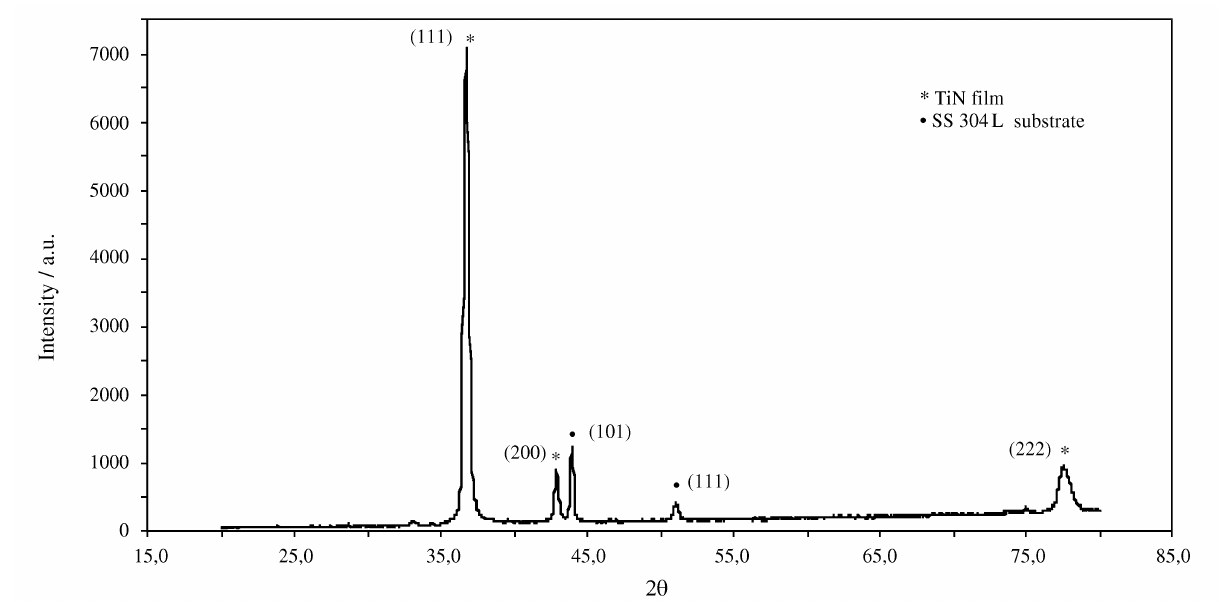
Figure 4. X-ray diffraction pattern for a TiN film after HIP